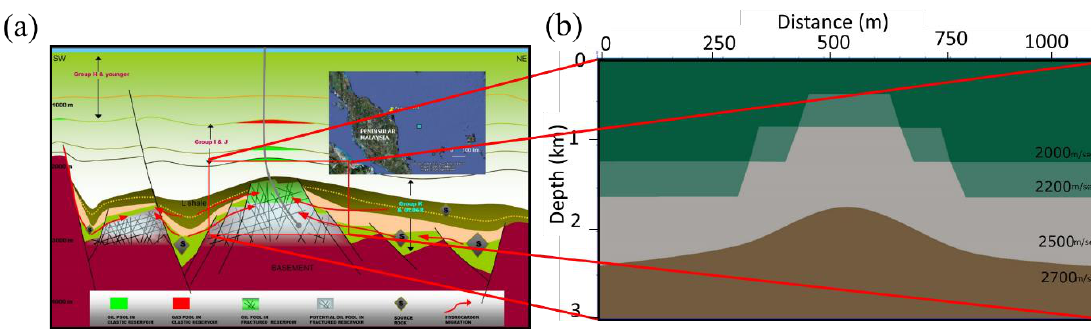
Figure5. ( a )MalayBasinfield, whichcontainsextensivefaultsandfracturesintheigneousbasement[28]. ( b ) Input initial velocity model for seismic analysis